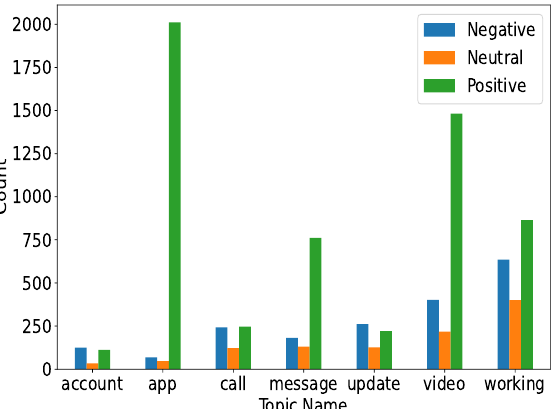
Figure 13. Sentiments regarding different features of